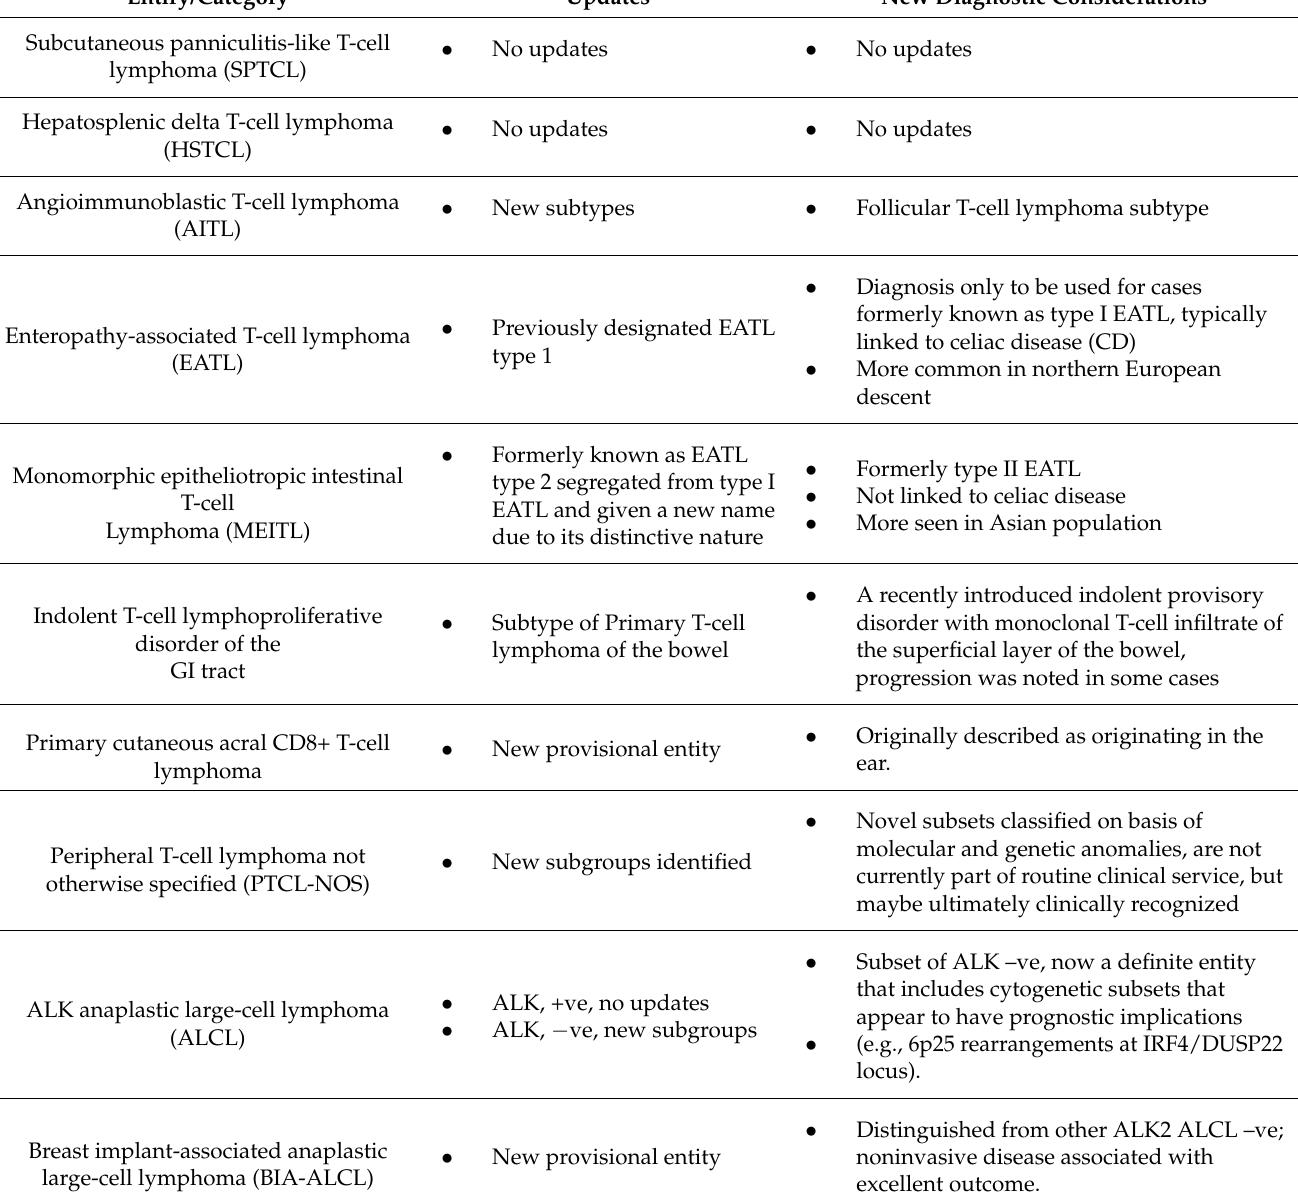
Table 2. Summary of changes contained in the updated 2016 WHO classification of T-cell lymphoid malignancies. New entities have been included, former entities have been reclassified, and some provisional entities have been “promoted” to reflect the advancement of our understanding of lymphoma molecular biology and clinical